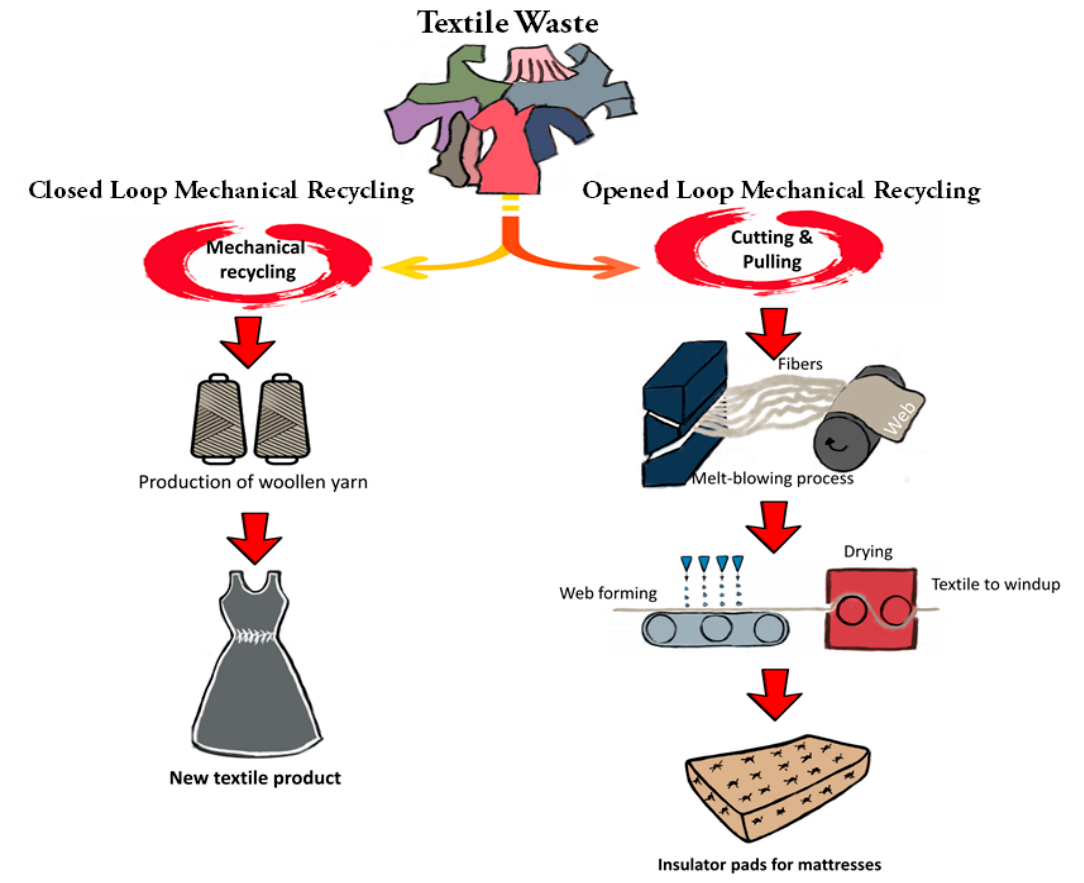
Figure 4. The recycling of garments by open and closed-loop systems.